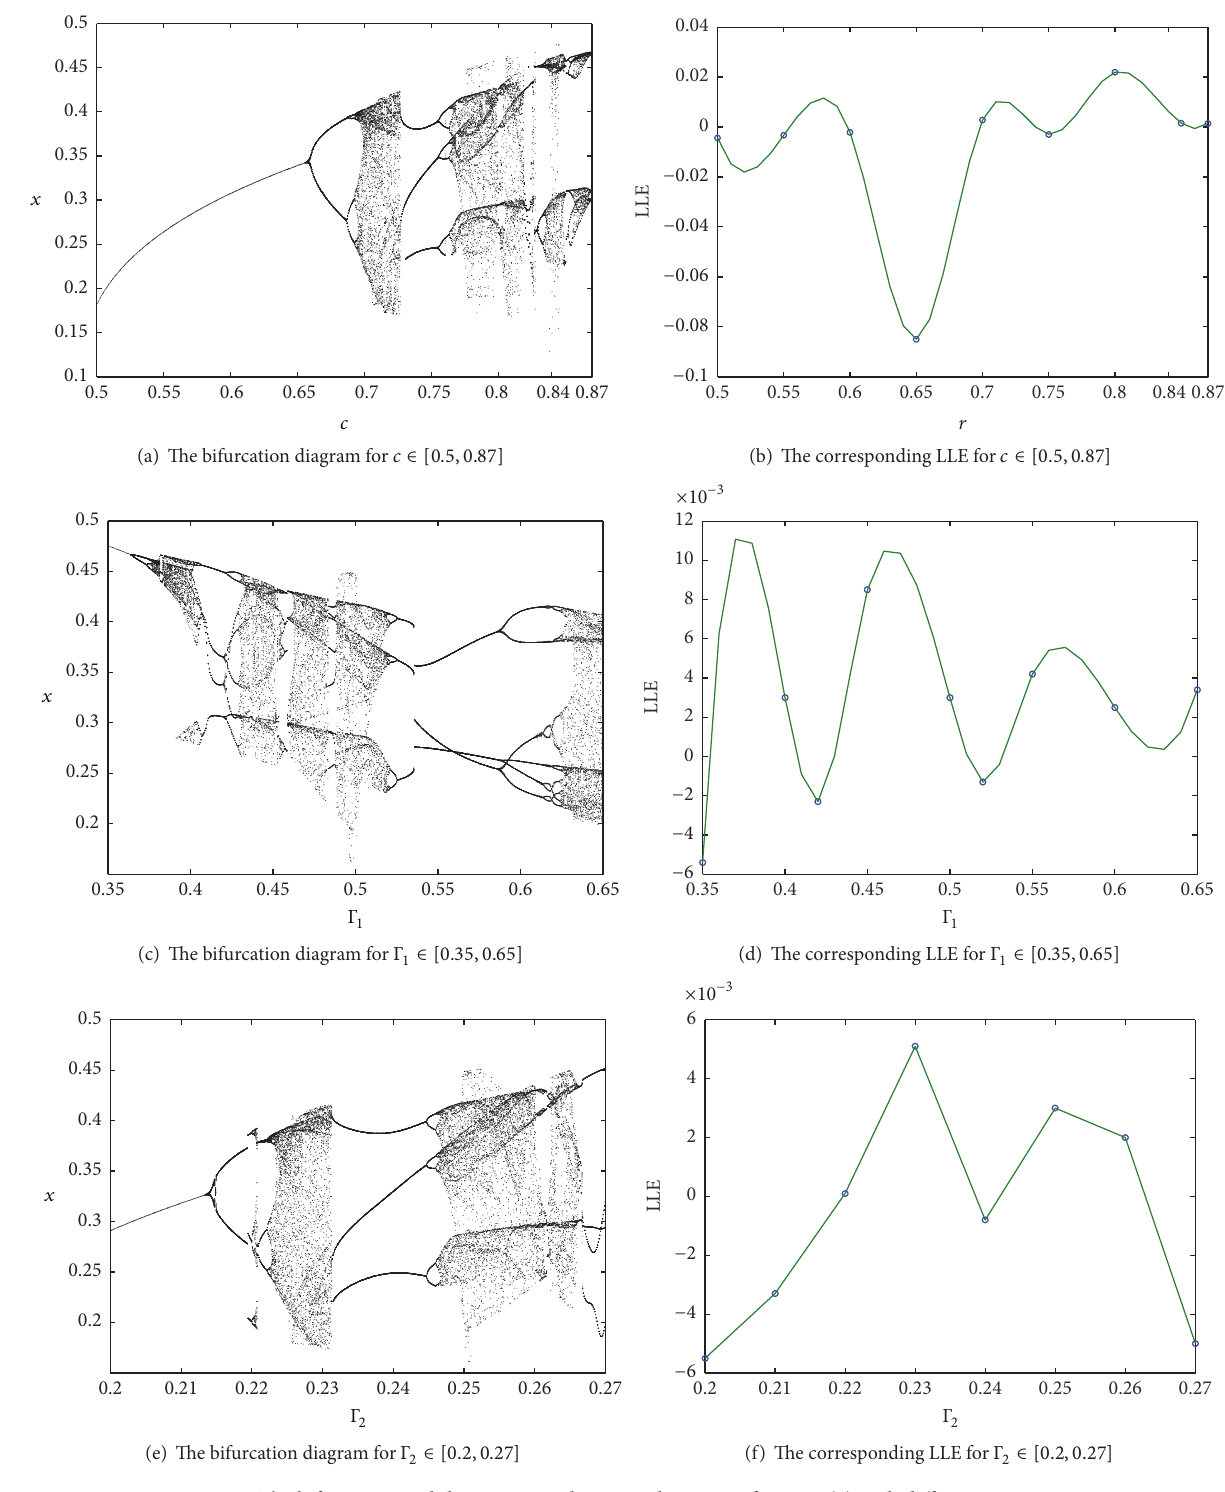
Figure 8: The bifurcation and the corresponding LLE diagrams of system (2) with different